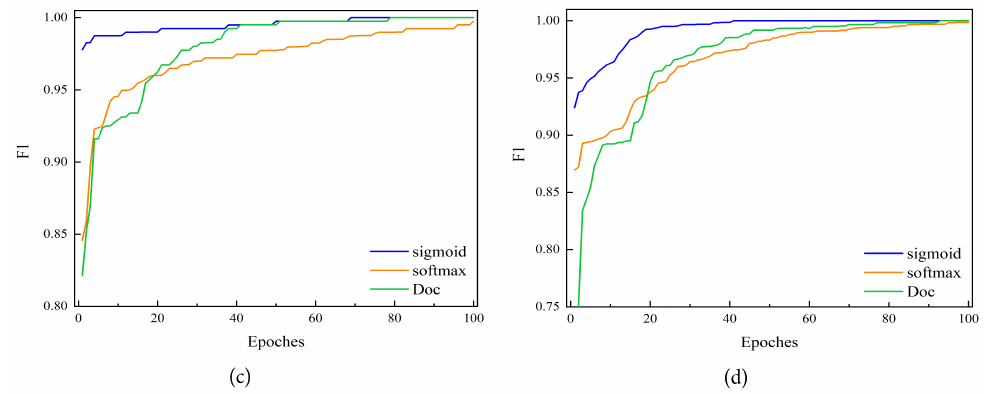
Figure 16. The experimental results of three methods on four datasets: ( a ) CRWU; ( b ) JNU; ( c ) SEU; and ( d )